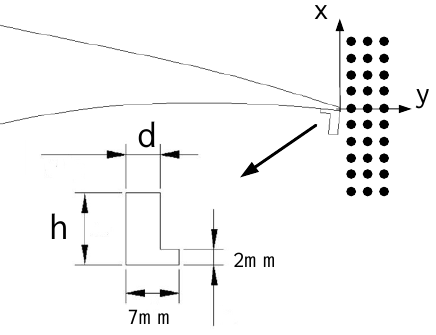
Figure 6. Flap Figure 6. Flap geometry. Figure 6. Flap geometry. Figure 6. Flap geometry.